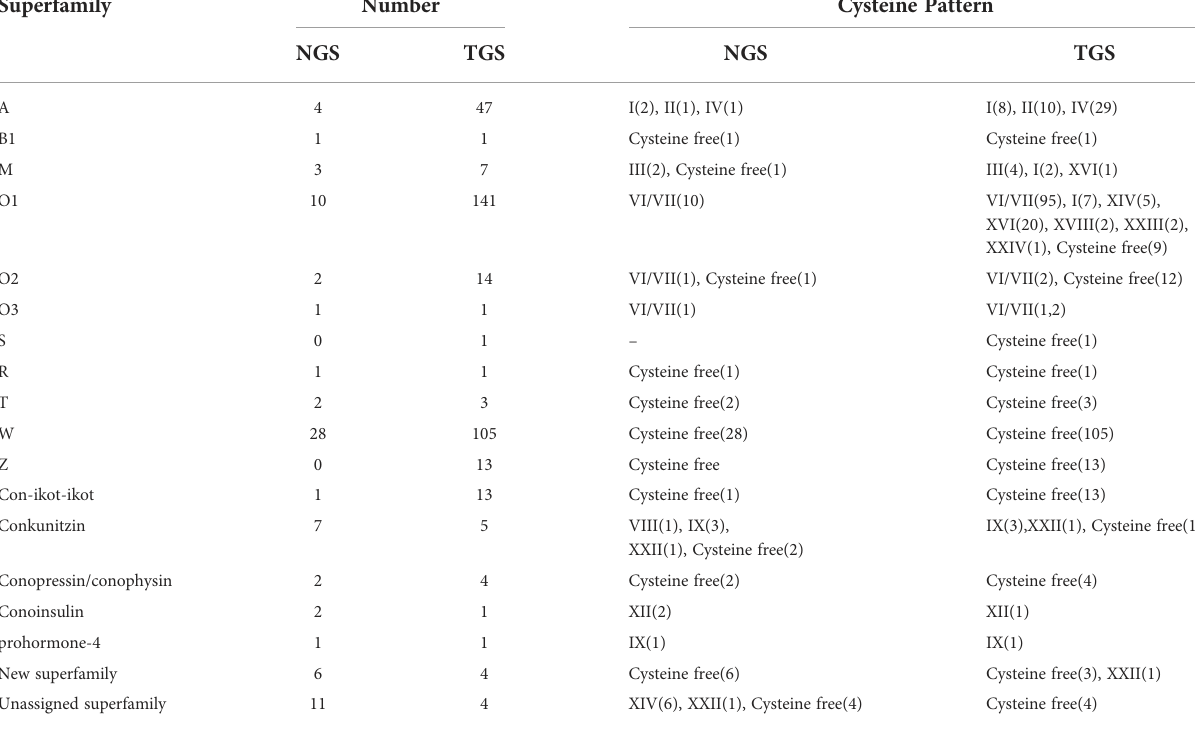
TABLE 3 Summary of identi fi ed superfamilies and cysteine frameworks of conotoxins.